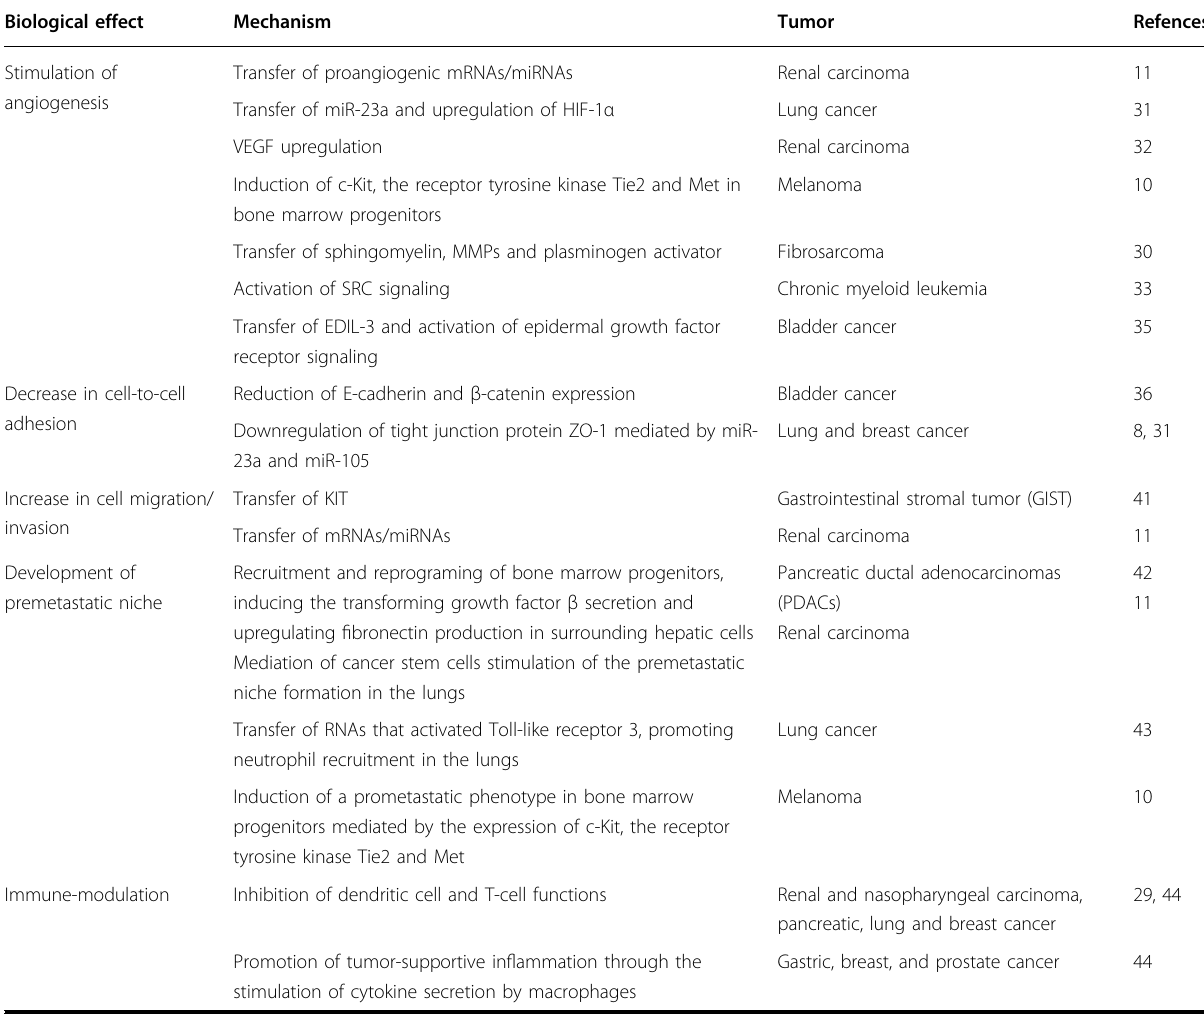
Table 1 Role of cancer-derived EVs in tumor progression Biological